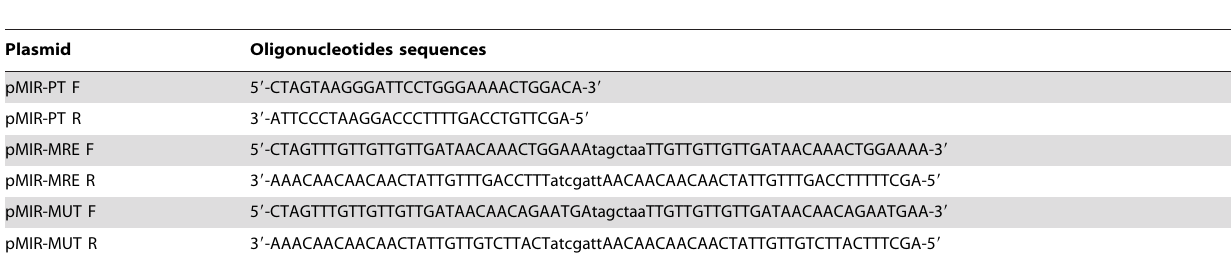
Table 1. Synthesized oligonucleotides sequences for generation of luciferase reporter constructs.